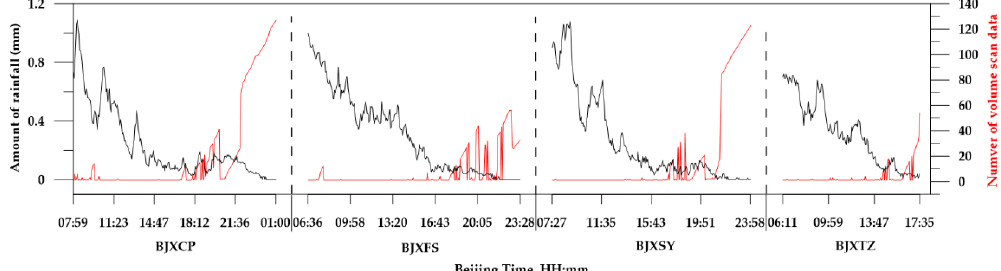
Figure 5. Temporal variations of the average amount of rainfall (black curve) in the regions between X-POL and CINRAD / SA radar sites and the needed number of volume scanned data (red curve) for obtaining real-time ratios a through using dynamic RIC. The rainfall data were collected by automatic meteorological observation stations (AMOSs) in the rain event on 20 July 2016 (Beijing Time). The conditions were that the di ff erences between the ranges from the AMOS site to the X-POL radar site and the ranges from the AMOS site to the CINRAD / SA radar site were less than 10 km. Between the covered observation regions of BJSDX and BJXCP sites (BJXFS, BJXSY, or BJXTZ site), 166